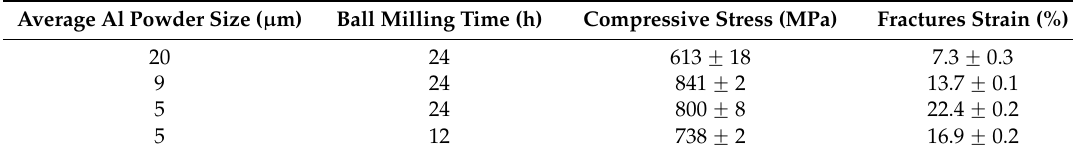
Table 3. Compressive strength and fracture strain of the sintered